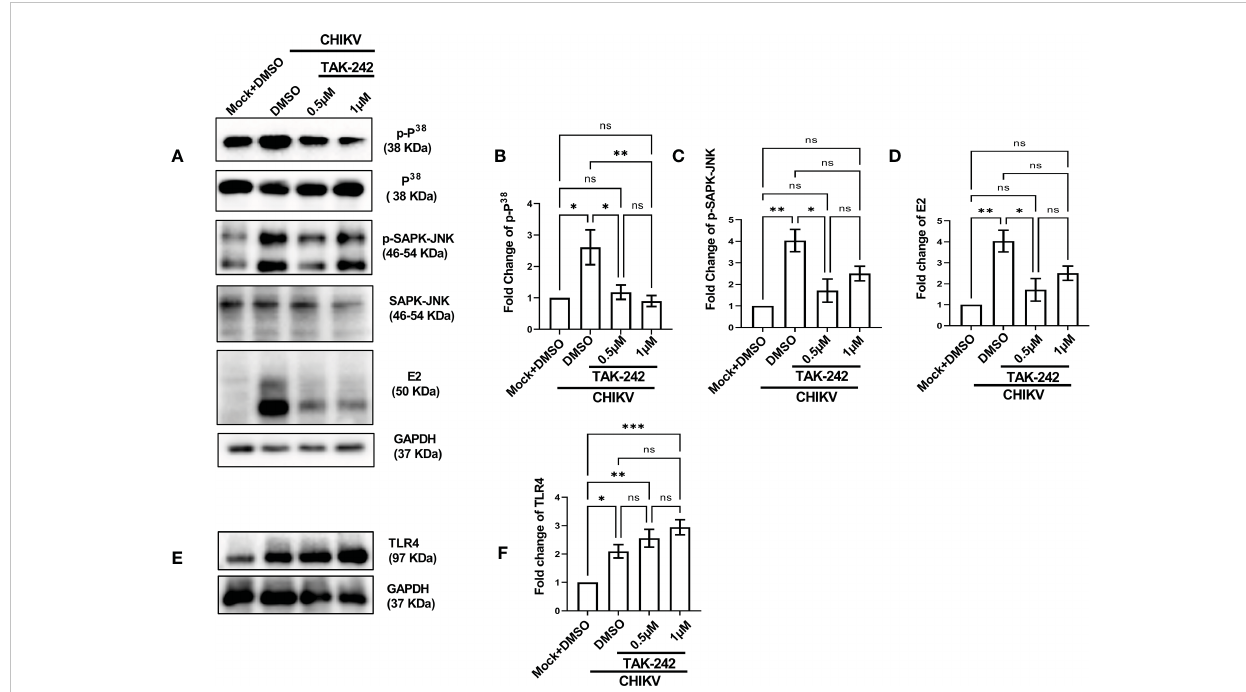
FIGURE 2 TLR4 inhibition lowers p38 and SAPK-JNK phosphorylation in host macrophages, in vitro . RAW264.7 cells were either pre-treated with DMSO or TAK-242 for 3 h before CHIKV infection. The CHIKV infection was given at 5 MOI for 2 h followed by the cells were harvested at 8 hpi. (A – D) Western blot analysis showing differential expression of p-P 38 , p-SAPK-JNK, E2 and their quanti fi cation normalized against GAPDH, in respective order. ( E, F ) Western blot analysis showing TLR4 expression with the corresponding quanti fi cation normalized against GAPDH. Data represent the Mean ± SEM of three independent experiments. p < 0.05 was considered as a statistically signi fi cant difference between the groups (ns: non- signi fi cant, * p <0.05; ** p ≤ 0.01; *** p ≤